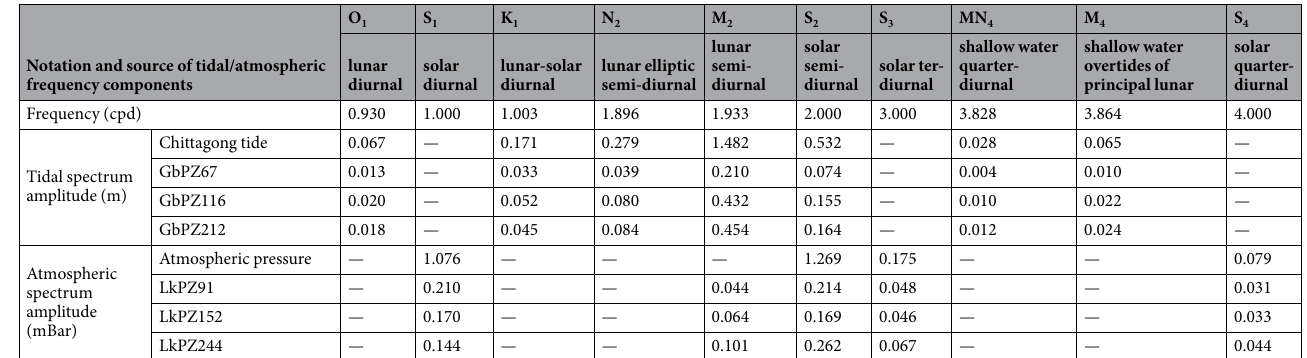
Table 1. Summary of the frequency components and amplitudes of the tidal and atmospheric signals and the groundwater responses at the Gabura and Laksmipur monitoring boreholes. Frequency component names follow the U.S. National Oceanic and Atmospheric Administration Tide and Current Glossary 18 . Note that the M 2 lunar semi-diurnal component in the Laksmipur (Lk) measurements is a response to earth